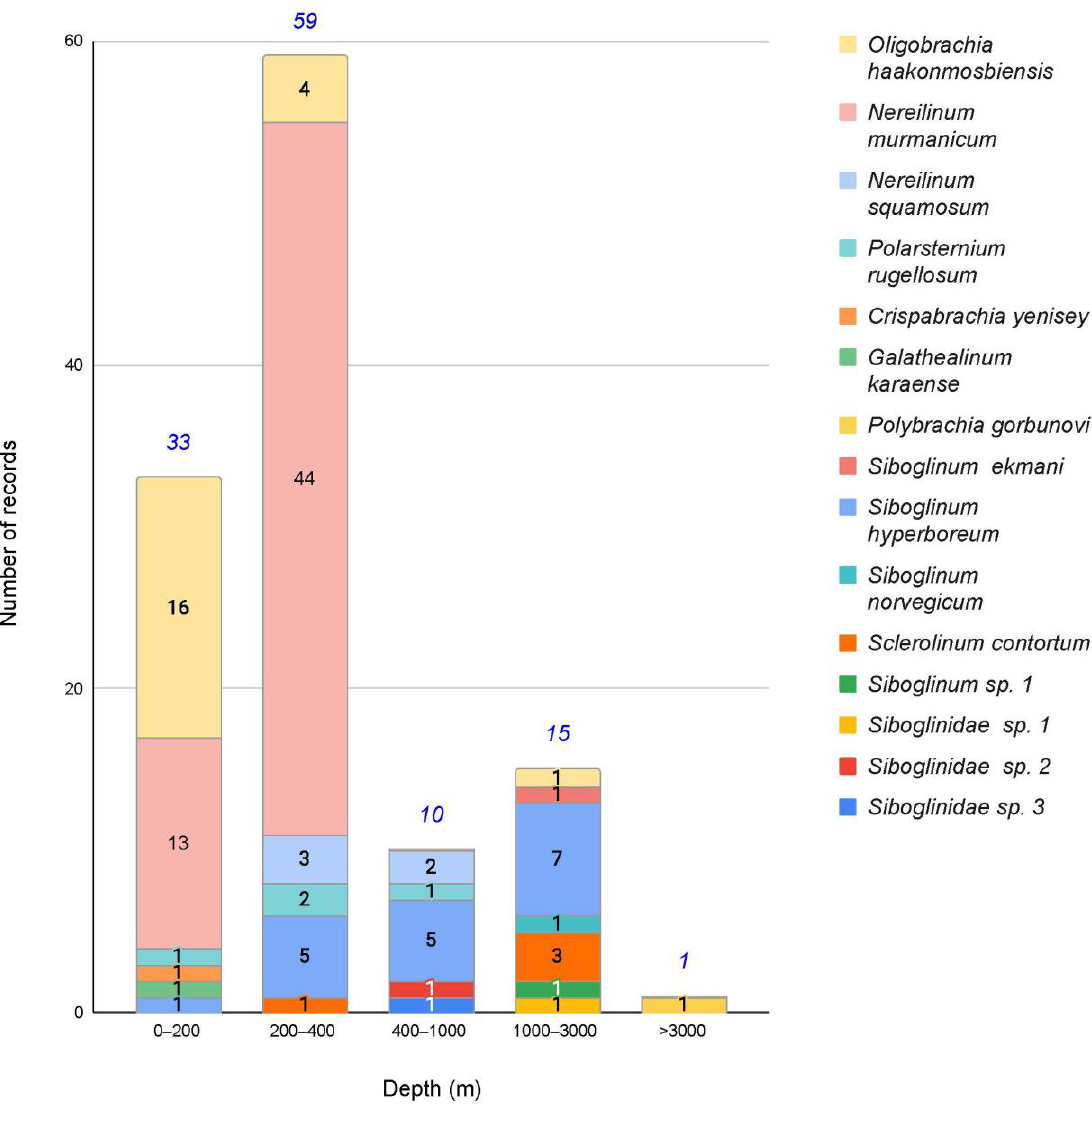
Figure 2. Distribution of siboglinid records by depth. The numbers indicate the number of records at a given depth range. The number of records of the corresponding species are indicated in black; the total number of siboglinid finds of the current depth range is indicated in blue italics.